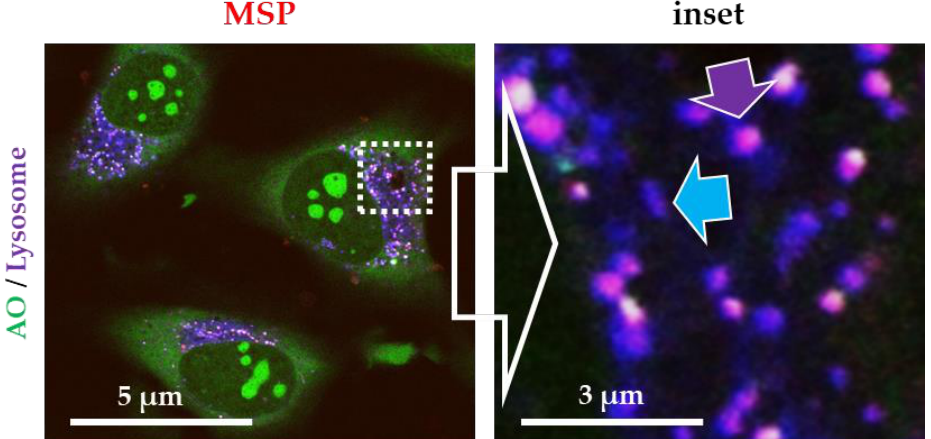
Figure 1. Fluorescent confocal microscopy images of live HeLa cells exposed to rhodamine B isothiocyanate (RBITC)-labelled mesoporous silica particles (MSP). Cell were stained with acridine orange (AO, green channel) and a specific marker for lysosomes (Lysotracker ® , blue channel). All intracellular MSP were contained inside lysosomes (purple arrow). Empty lysosomes are labelled in blue (blue arrow). Free cytosolic particles (only red fluorescence) were not